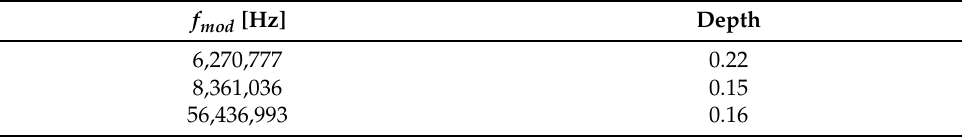
Table A2. Modulation frequencies and depths for the simulated